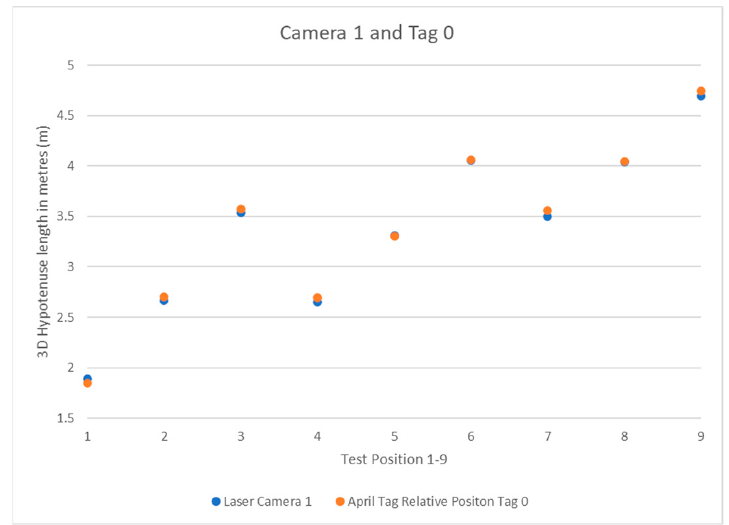
Figure 11. Camera 1 and Tag 0 Position Results.